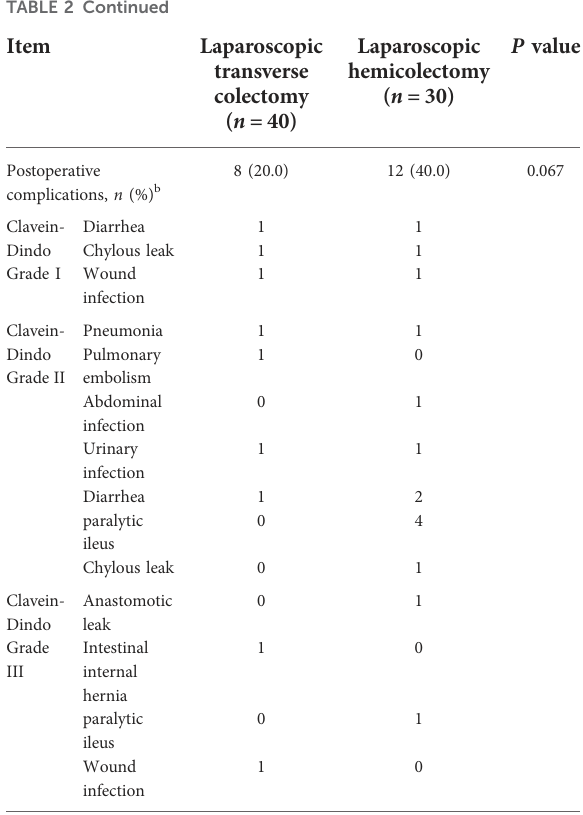
TABLE 2 Operative details and postoperative short-term